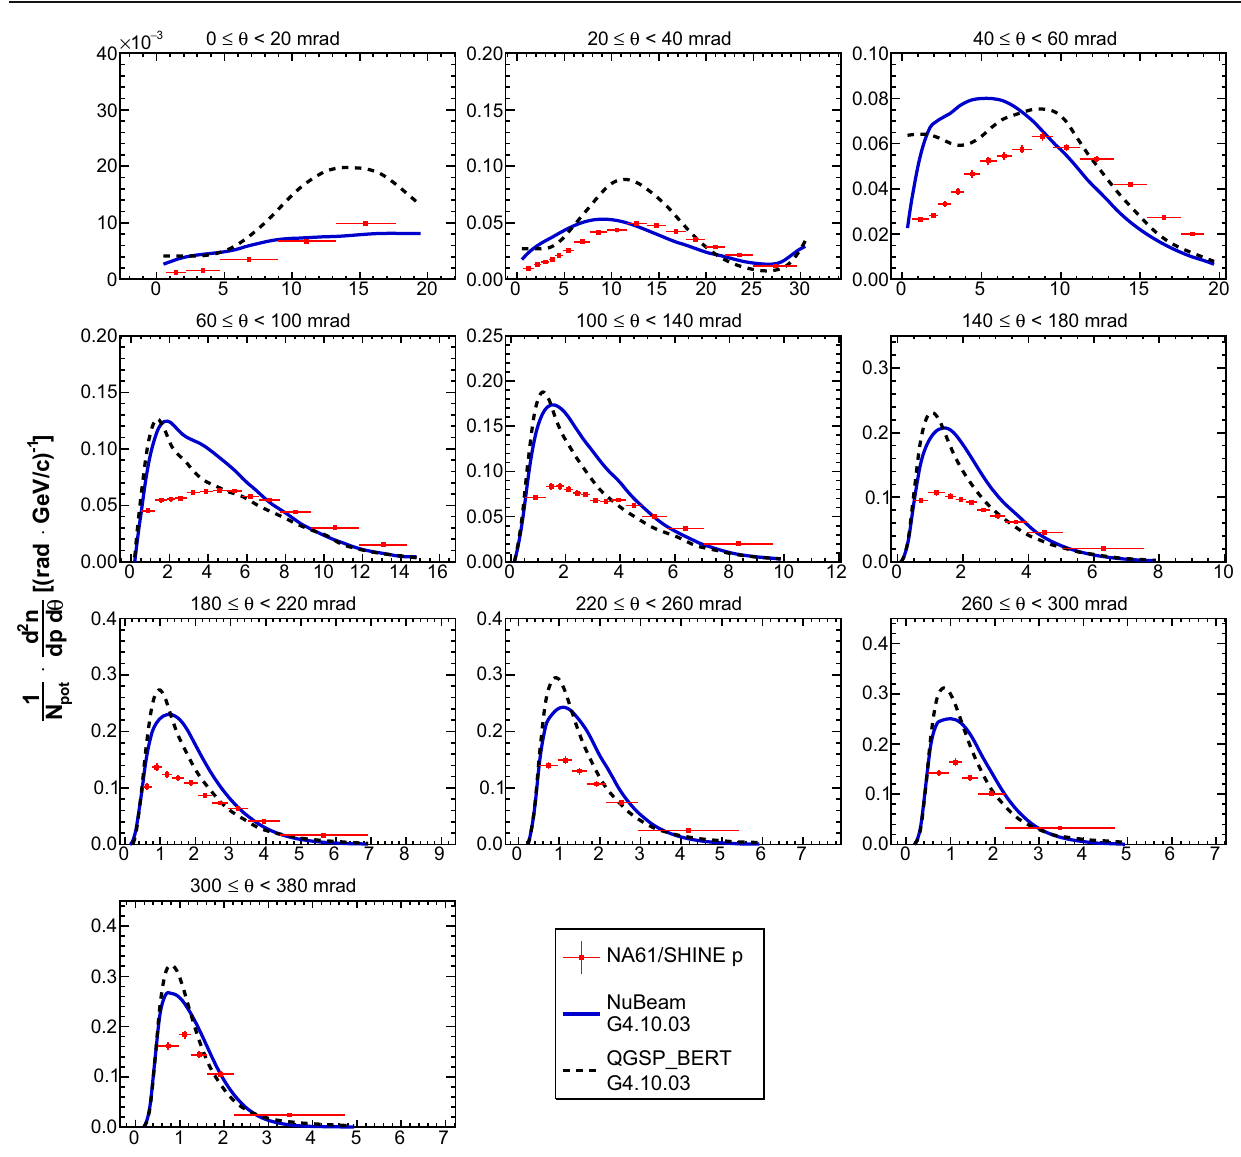
QGSP_BERT (dashed black line) physics lists from Geant4.10 .03 [27,28] are overlaid on top of the data